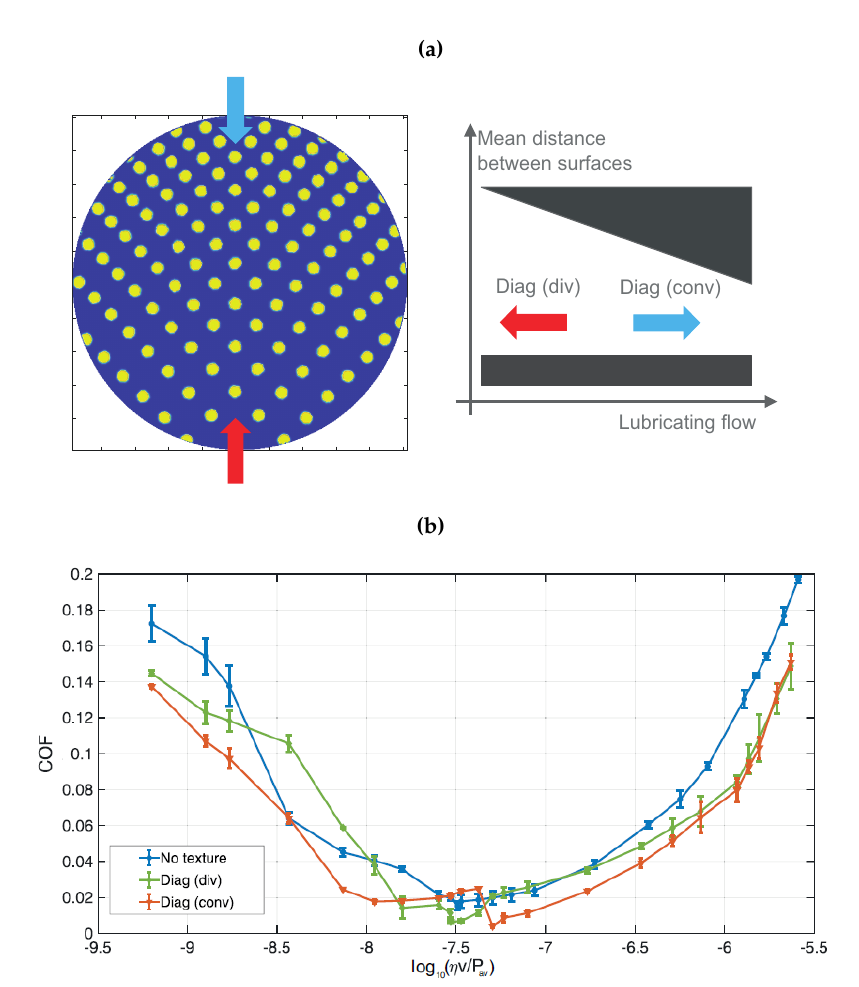
Figure 12. Coefficient of friction (COF) as a function of the Hersey number log unxtextured sample, the Fishbone and the rotated Fishbone textures (as shown in the schematics on the right). The load is constant and equal to 1 N.